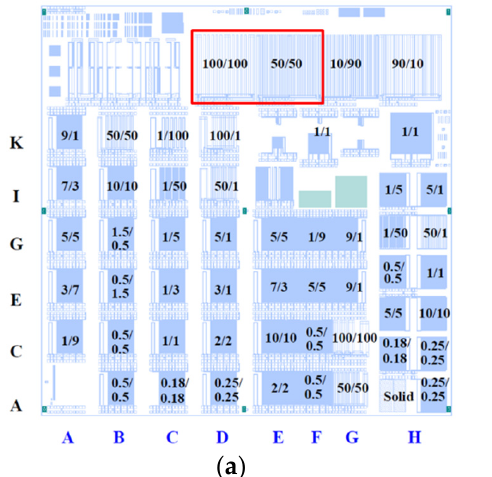
Table 1. Experimental conditions based on the wafer type for global planarization.